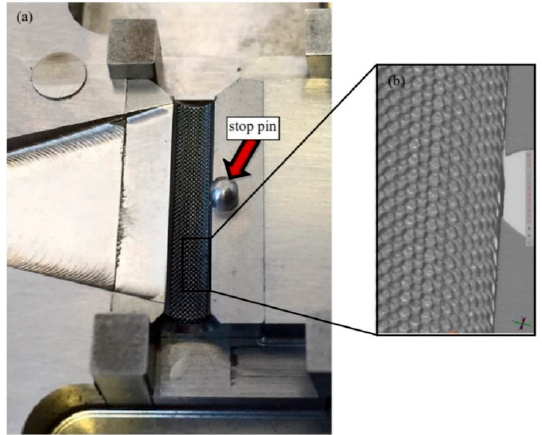
Figure 11. Final tool for overmolding ( a ) with additional stop pin to prevent bending of the metal screw insert and ( b ) 3D scan of the surface details.